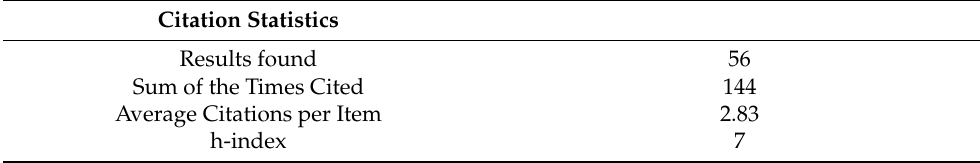
Table 2. The citation rate of publications in Web of Science database relating a robot tax in 2000-2021. Citation Statistics